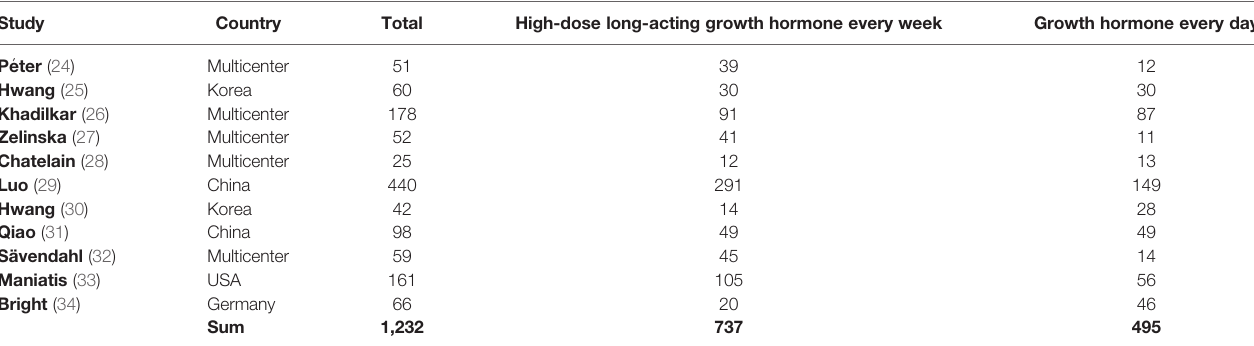
TABLE 2 | Characteristics of the selected studies for the meta-analysis.